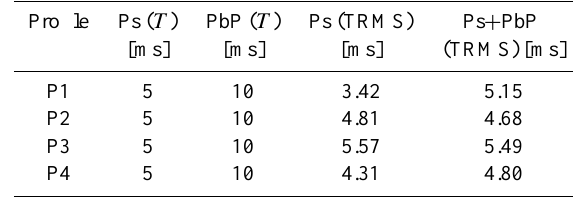
Table 2. Summary of travel-time picks and details of the average fi- nal velocity–depth model shown in Figs. 5–8. The nomenclature is as follows: Ps (refractions), PbP (reflections from the top of the sub- stratum), 1T (average travel-time uncertainty), and TRMS (root- mean-square travel–time misfit).